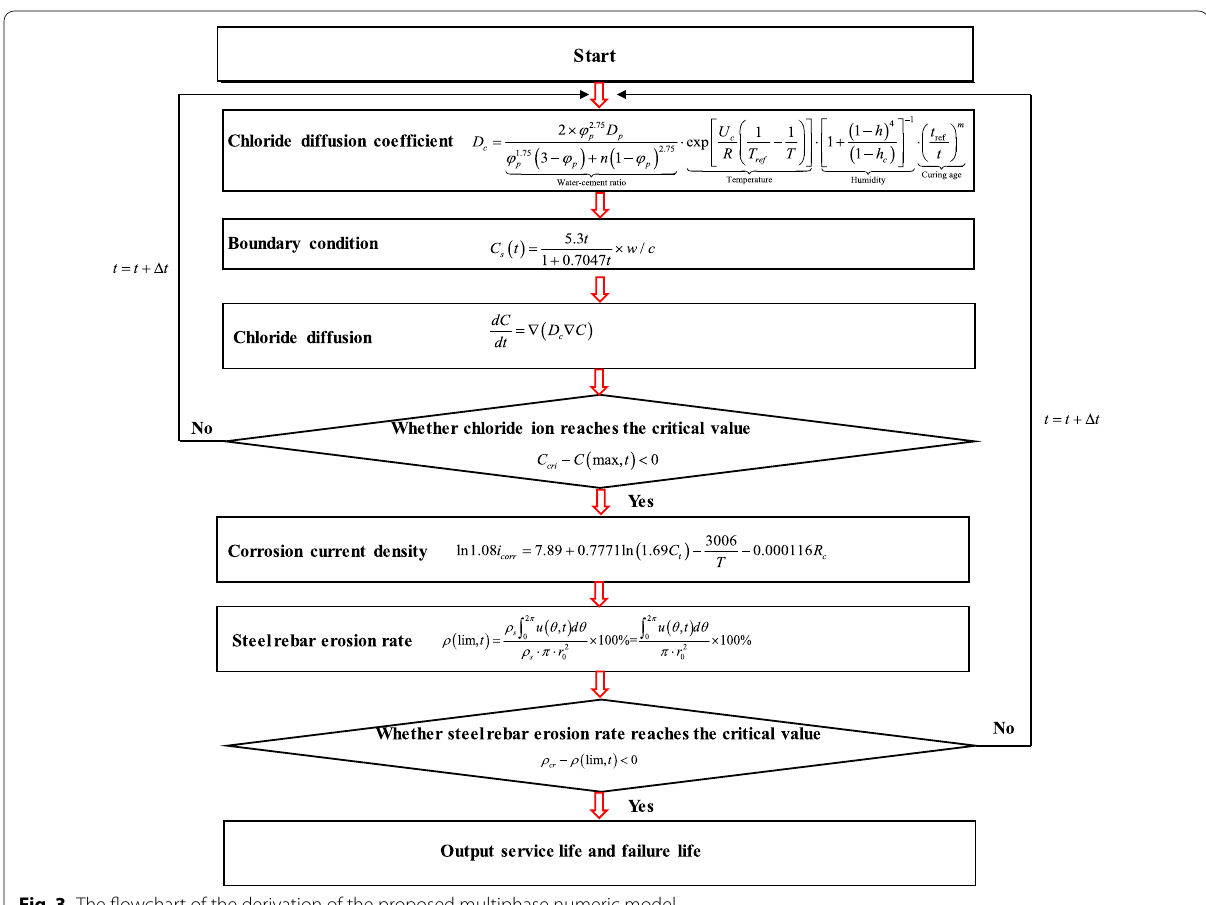
Fig. 3 The flowchart of the derivation of the proposed multiphase numeric